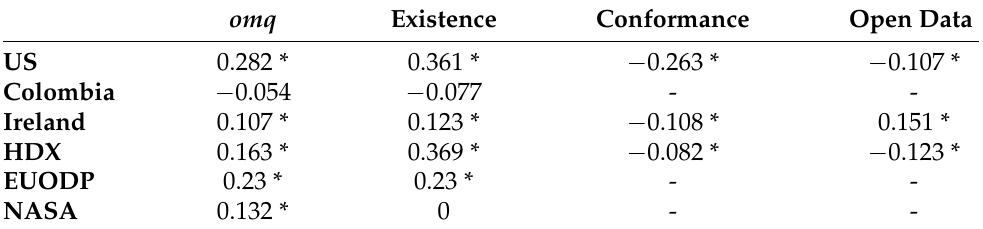
Figure 4. Correlation between overall metadata quality and the number of GOGD datasets’ views for the selected portals. Spearman’s ρ values with p < 0.05 postfixed with *. Table 6. Correlation values between number of Views and overall metadata quality ( omq ), and the three quality dimensions for the selected portals. Spearman’s ρ values with p < 0.05 postfixed with